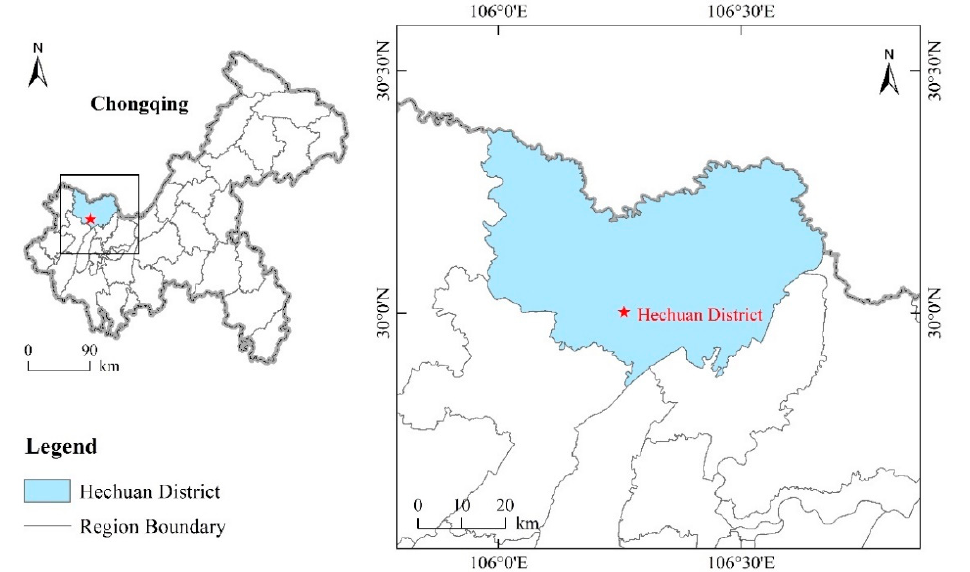
Figure 2. Map of the study area.